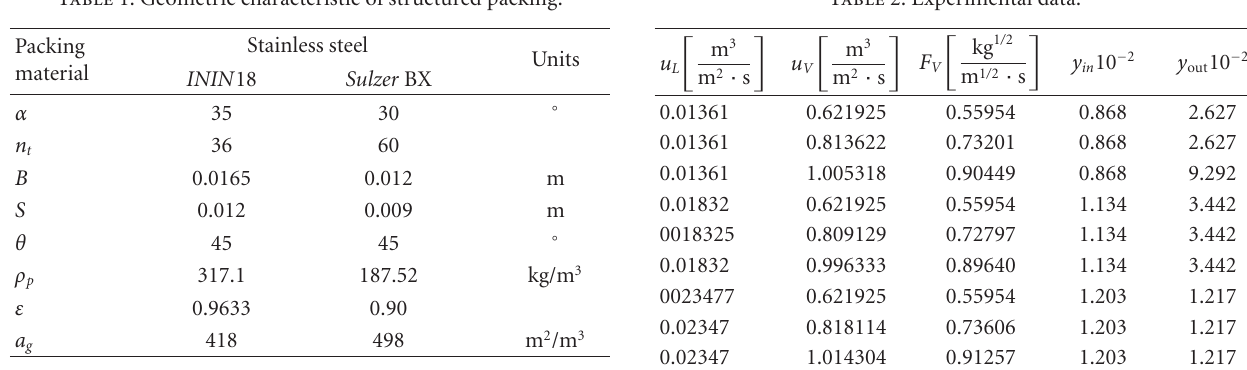
Figure 1: Experimental absorption process. Table 1: Geometric characteristic of structured packing. Table 2: Experimental